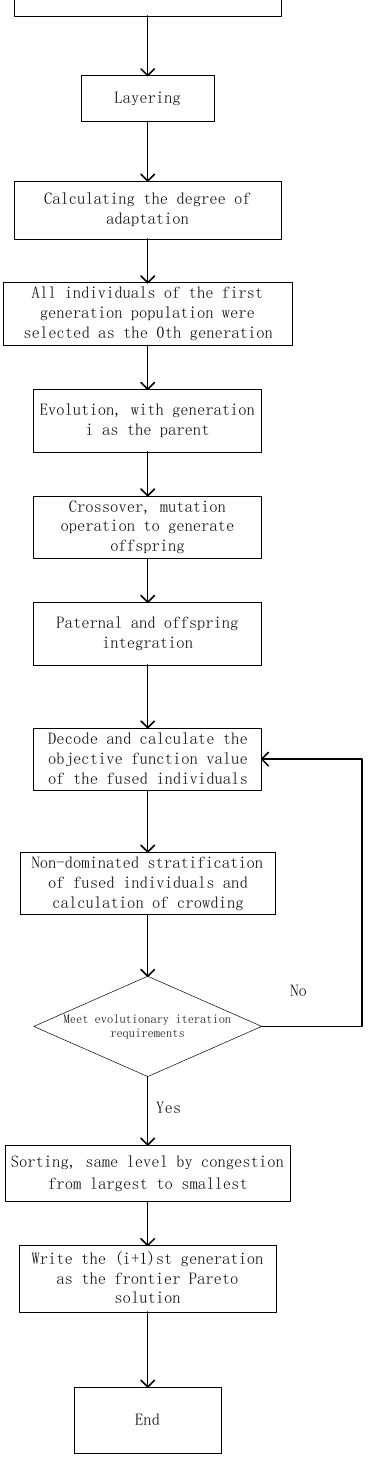
Figure 9. The basic process of mutation operation.